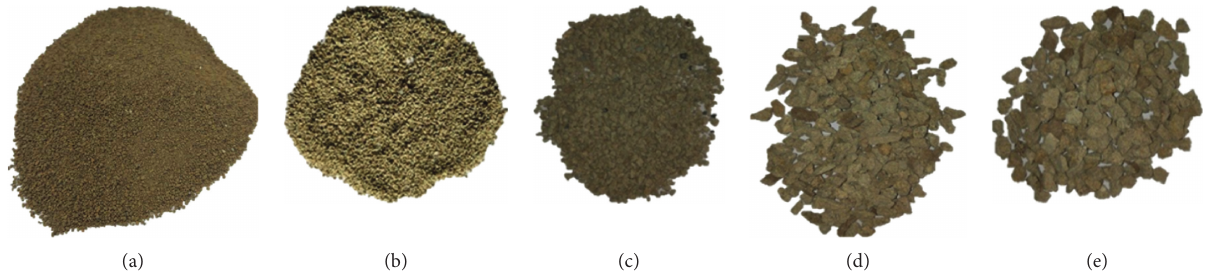
Figure 3: Sieved soil and sandstone: (a) 0 ∼ 1mm; (b) 1 ∼ 2mm; (c) 2 ∼ 5 mm; (d) 5 ∼ 8mm; (e) 8 ∼ 10mm.